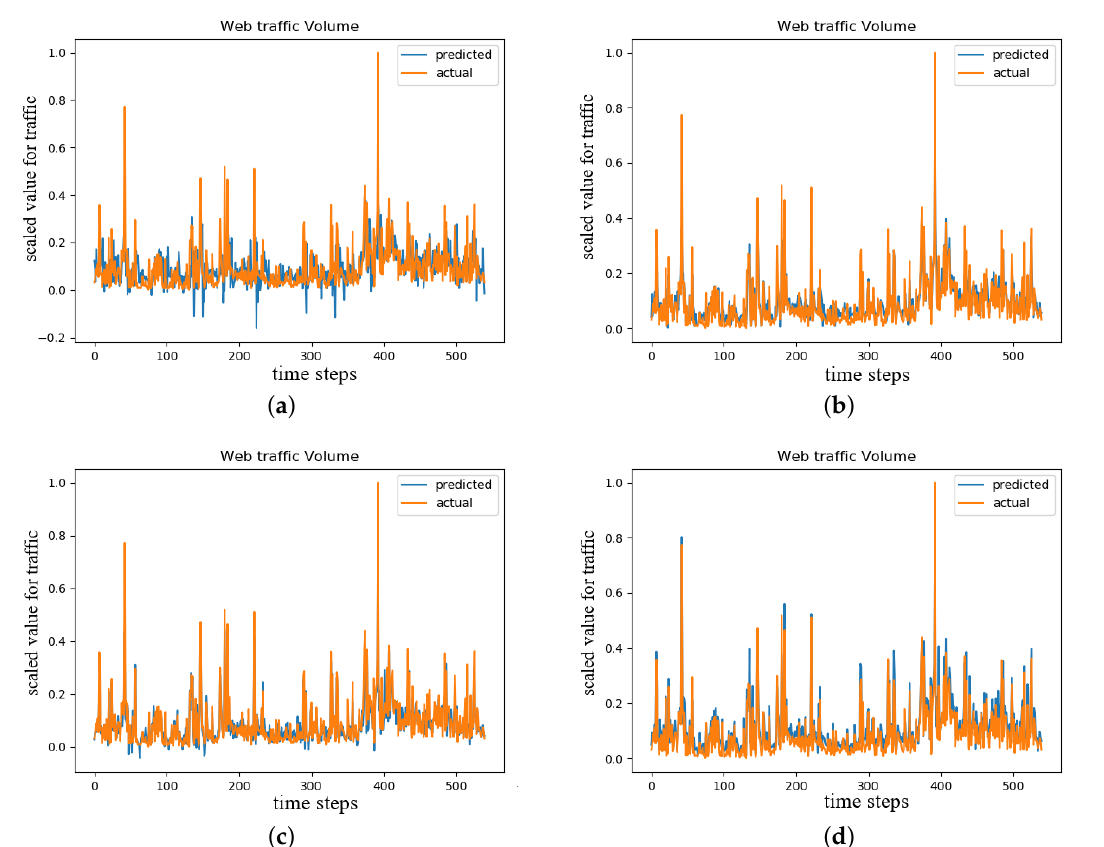
Figure 11. TCN with dilations test results for time series forecasting task ( a ) adadelta, ( b ) adagrad, ( c ) adam, ( d )